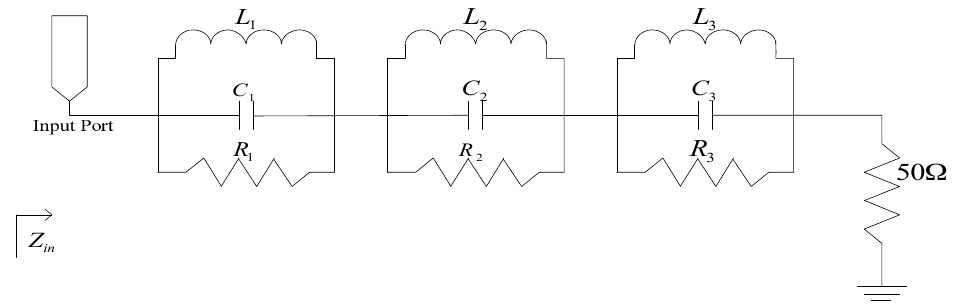
Figure 5. Schematic of the equivalent circuit model of the triple band-notched ultrawideband (UWB) antenna.